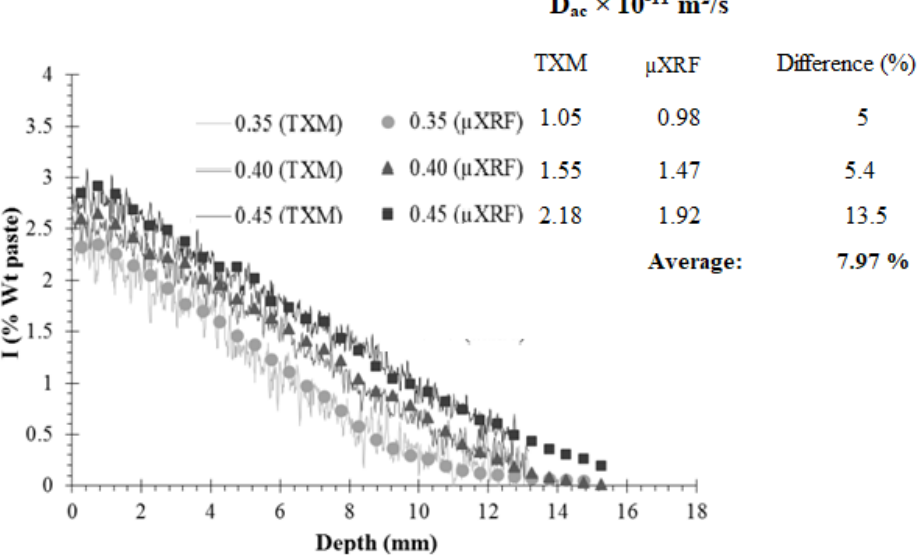
Figure A2. Comparison of TXM results with µXRF [27].